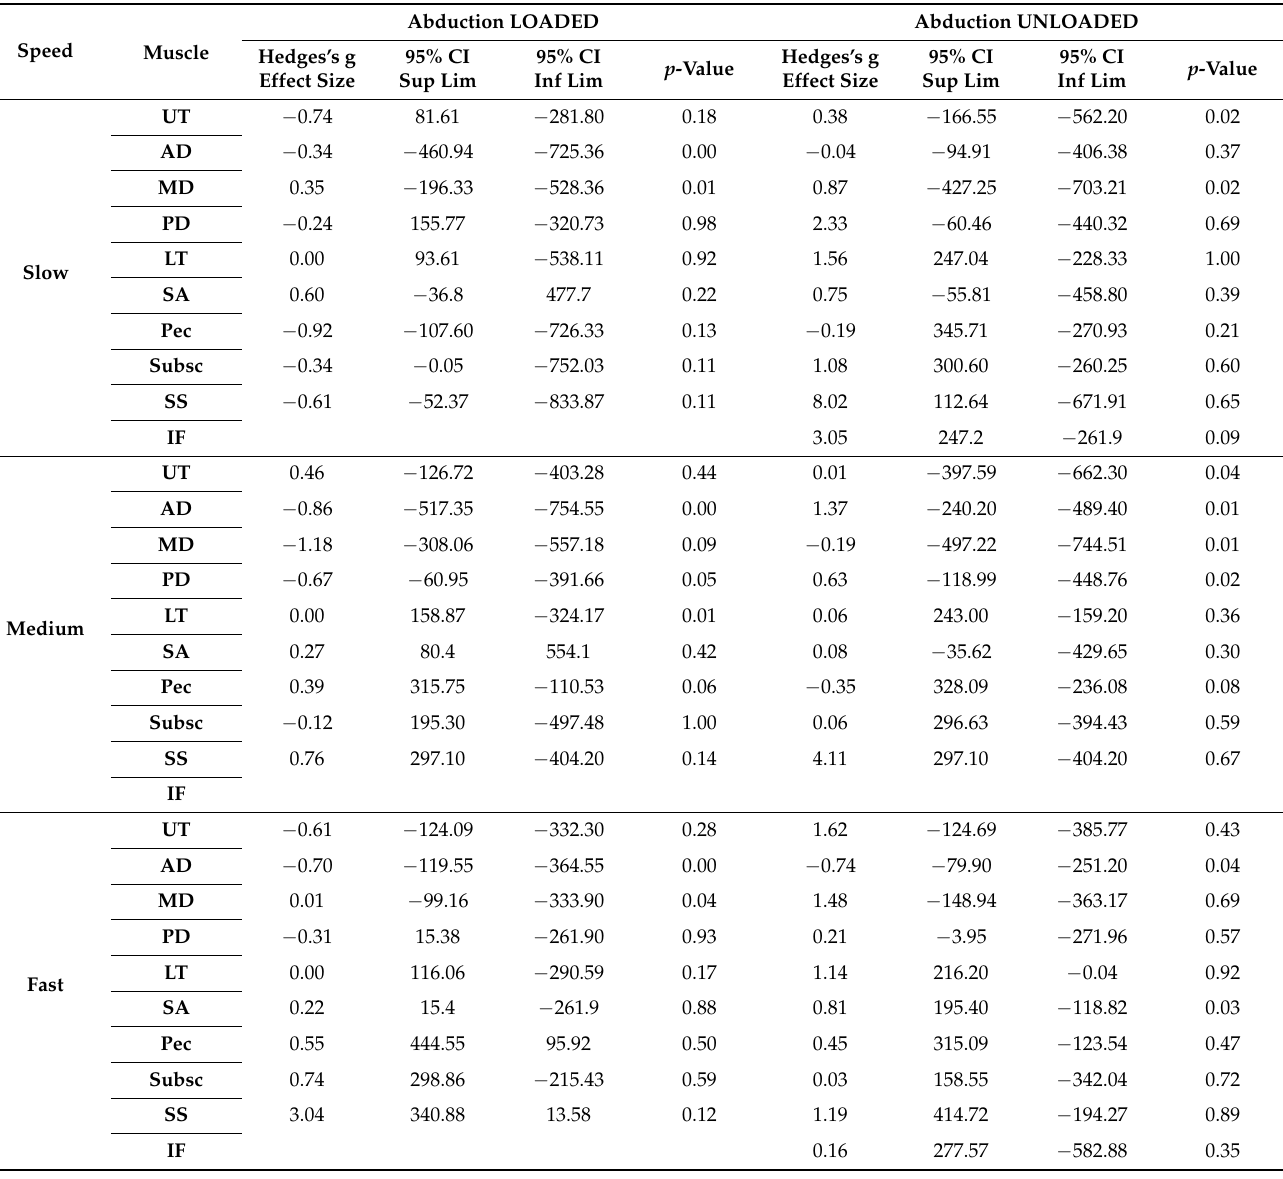
Table 4. Comparative statistics of EMG onset time of activation (ms) during abduction before and after standardized physiotherapy treatment for SIS movement at slow, medium and fast speeds; loaded and unloaded conditions. Abduction LOADED Abduction UNLOADED Speed Muscle